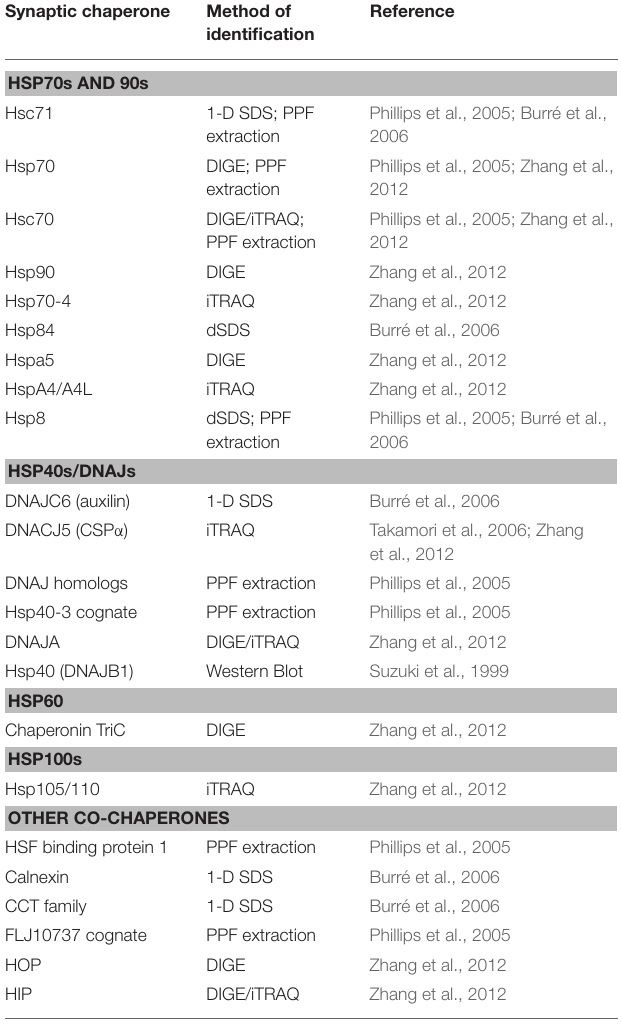
TABLE 1 | Summary of chaperones identified at the synapse. Synaptic